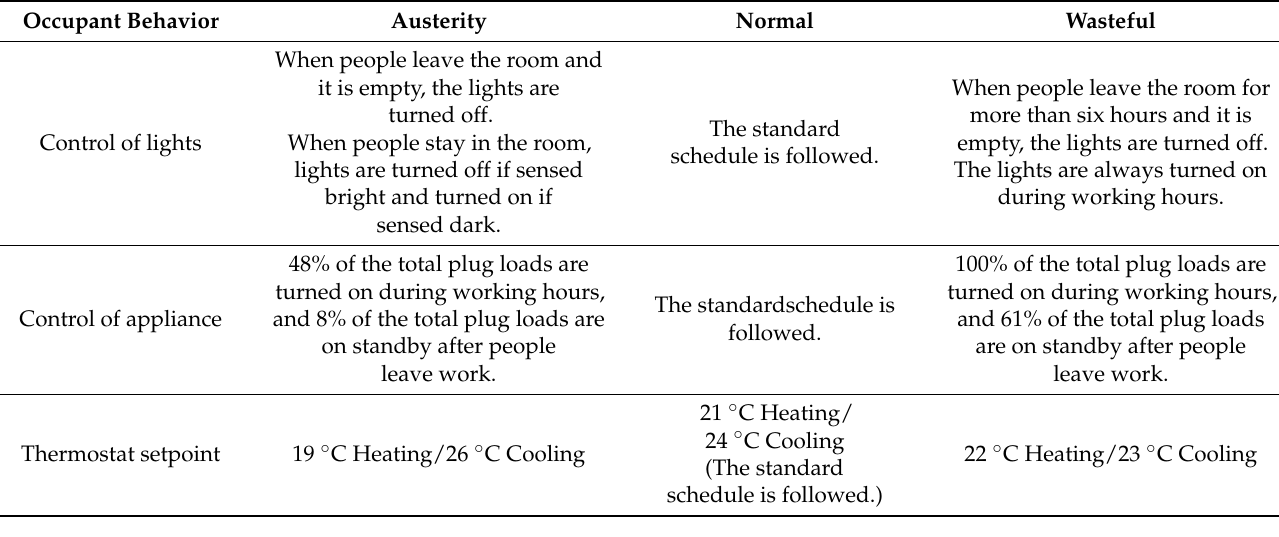
Table 5. Occupant interaction